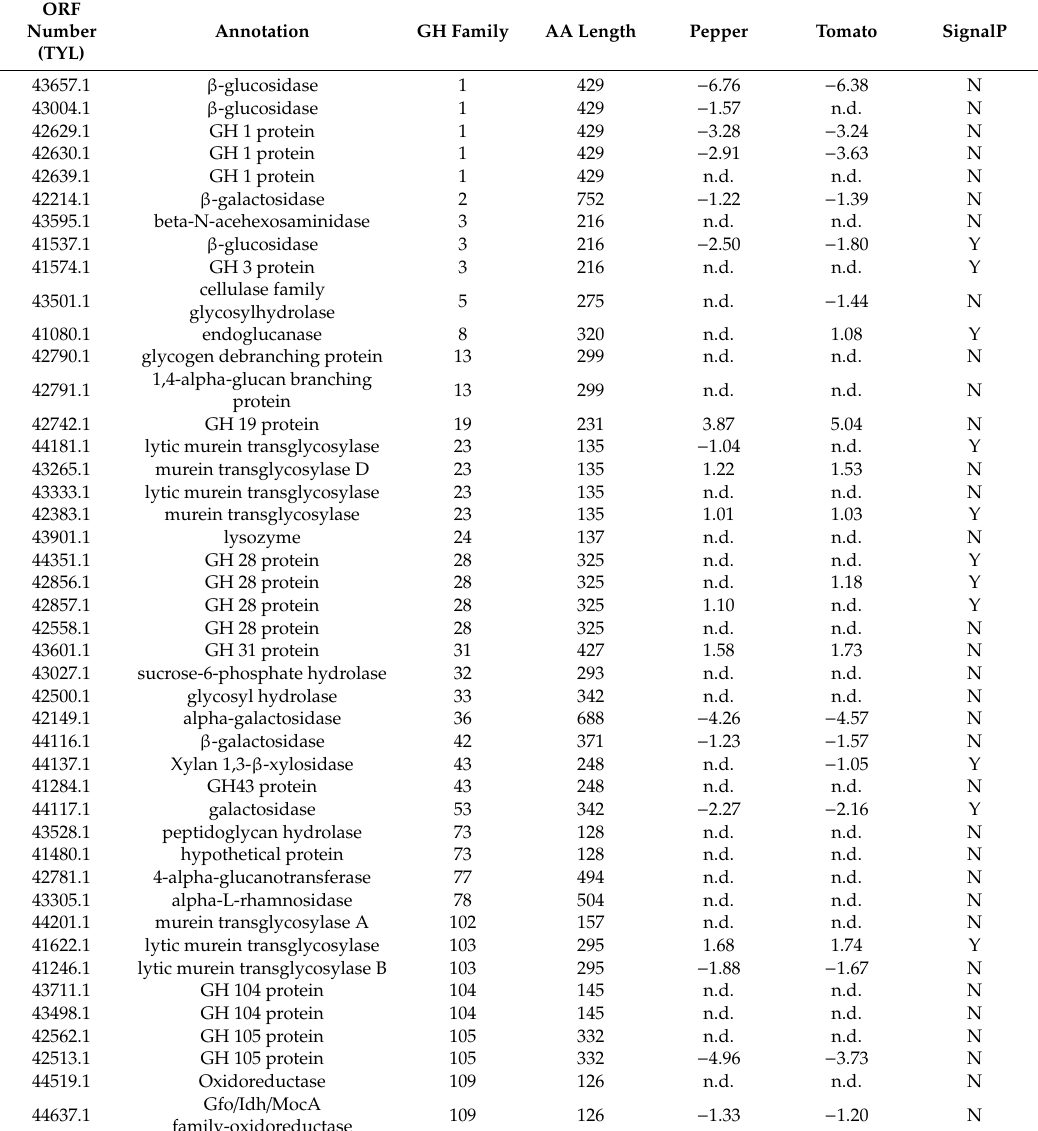
Table 2. Cellulose and hemicellulose degradation relevant enzymes and its transcriptome in sweet pepper or tomato compared to LB medium: glycoside hydrolase family